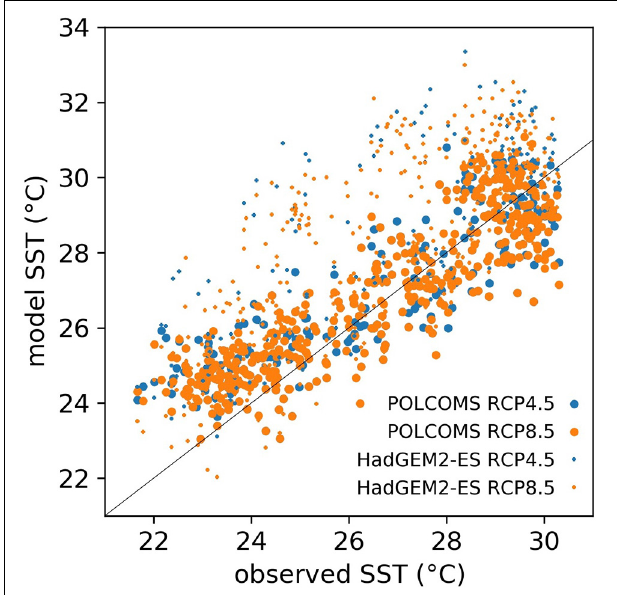
FIGURE 2 | Scatter plot between observed SST and model